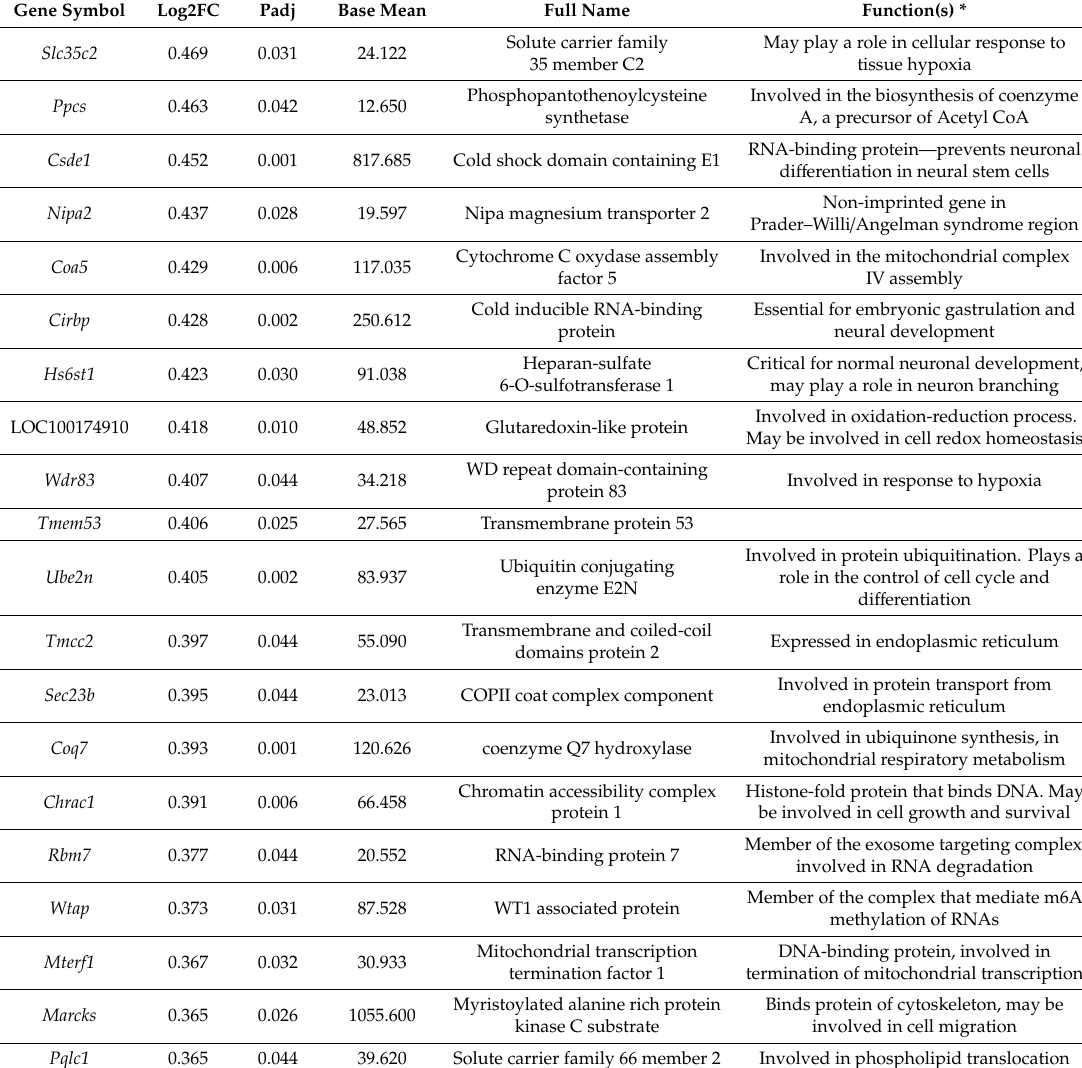
Table A1. Top 20 upregulated genes in the protein-restricted